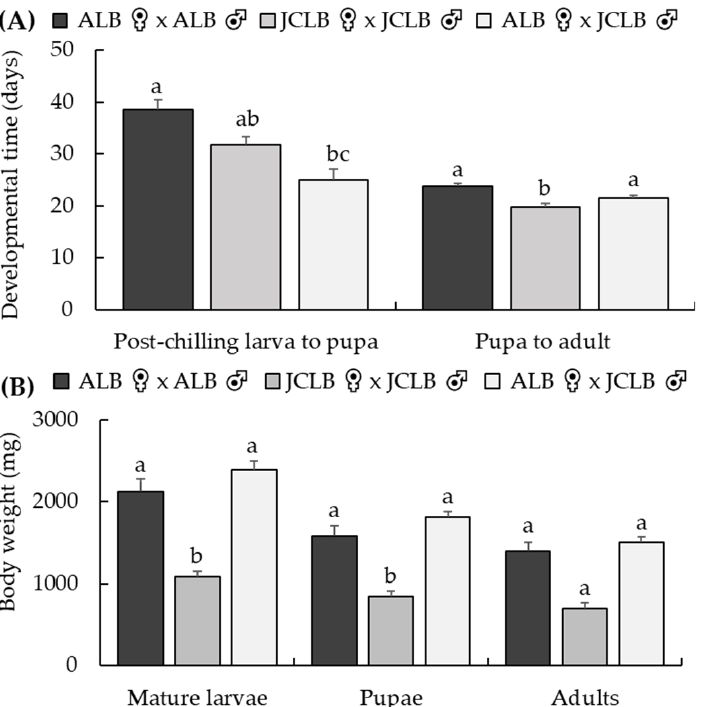
Figure 2. Crossing bioassays at BIIRU: developmental times ( A ) of post-chilled larvae and pupae of Anoplophora glabripennis (ALB) and A. malasiaca (JCLB) and body weights ( B ) of pre-chilling mature larvae, pupae and adults (B). Bars refer to mean + SE and different letters above the bars indicate significant difference (ANOVA, p < 0.05).